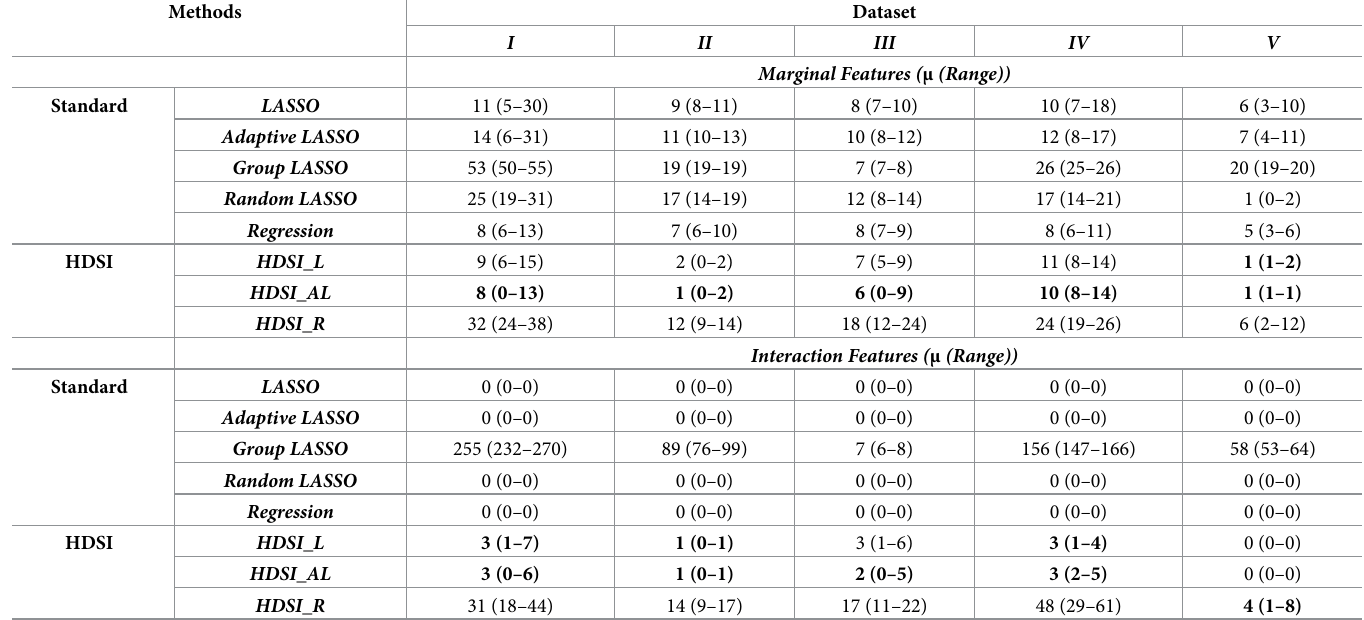
Table 7. Feature selection performance of different methods on the real datasets.